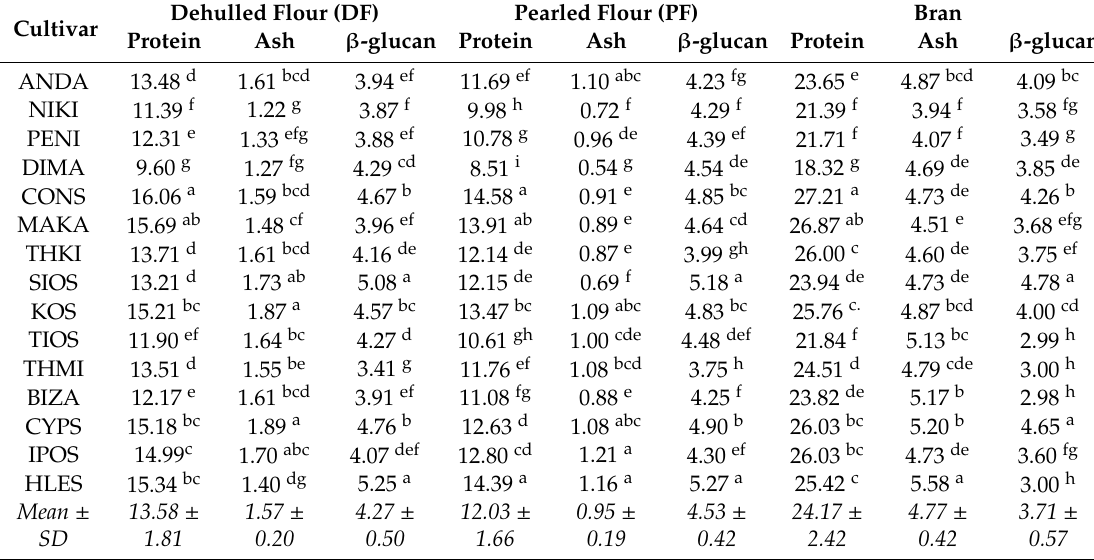
Table 3. Protein ash and β -glucan contents (%) of three fractions among barley cultivars tested.